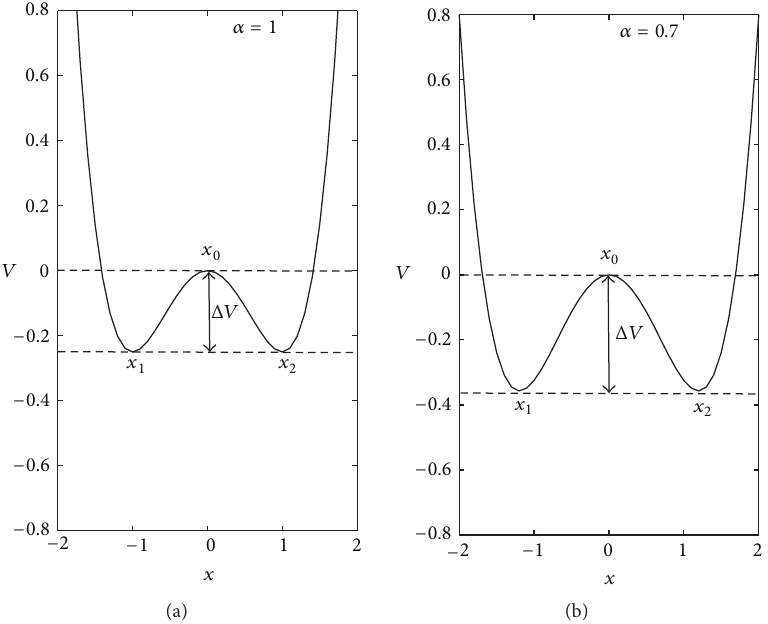
Figure 5: Potential 𝑉 (double-well) as a function of the state variable 𝑥 . The potential 𝑉 associated with the mechanistic model described by (1) is plotted for two values of the parameter 𝛼 controlling the height of the wells: (a) 𝛼 = 1 and (b) 𝛼 = 0.7. The variable 𝑥 represents the health state of a patient (i.e., the position of the particle in our metaphor). The health state is denoted by 𝑥 1 , the no health state by 𝑥 2 , and 𝑥 0 is the unstable steady state between them. Δ𝑉 is the barrier whose height is controlled by the parameter 𝛼 . Dashed lines denote the upper and lower bounds of the potential